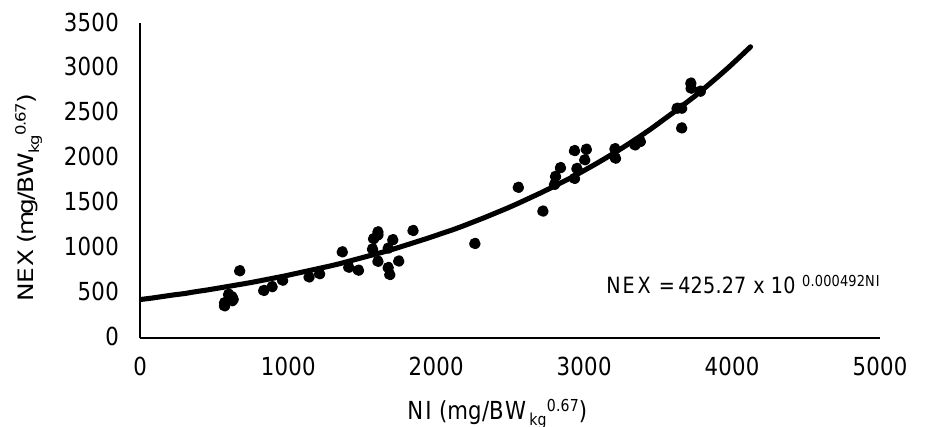
Figure 1. Estimation of the nitrogen requirements for maintenance by fitting an exponential function